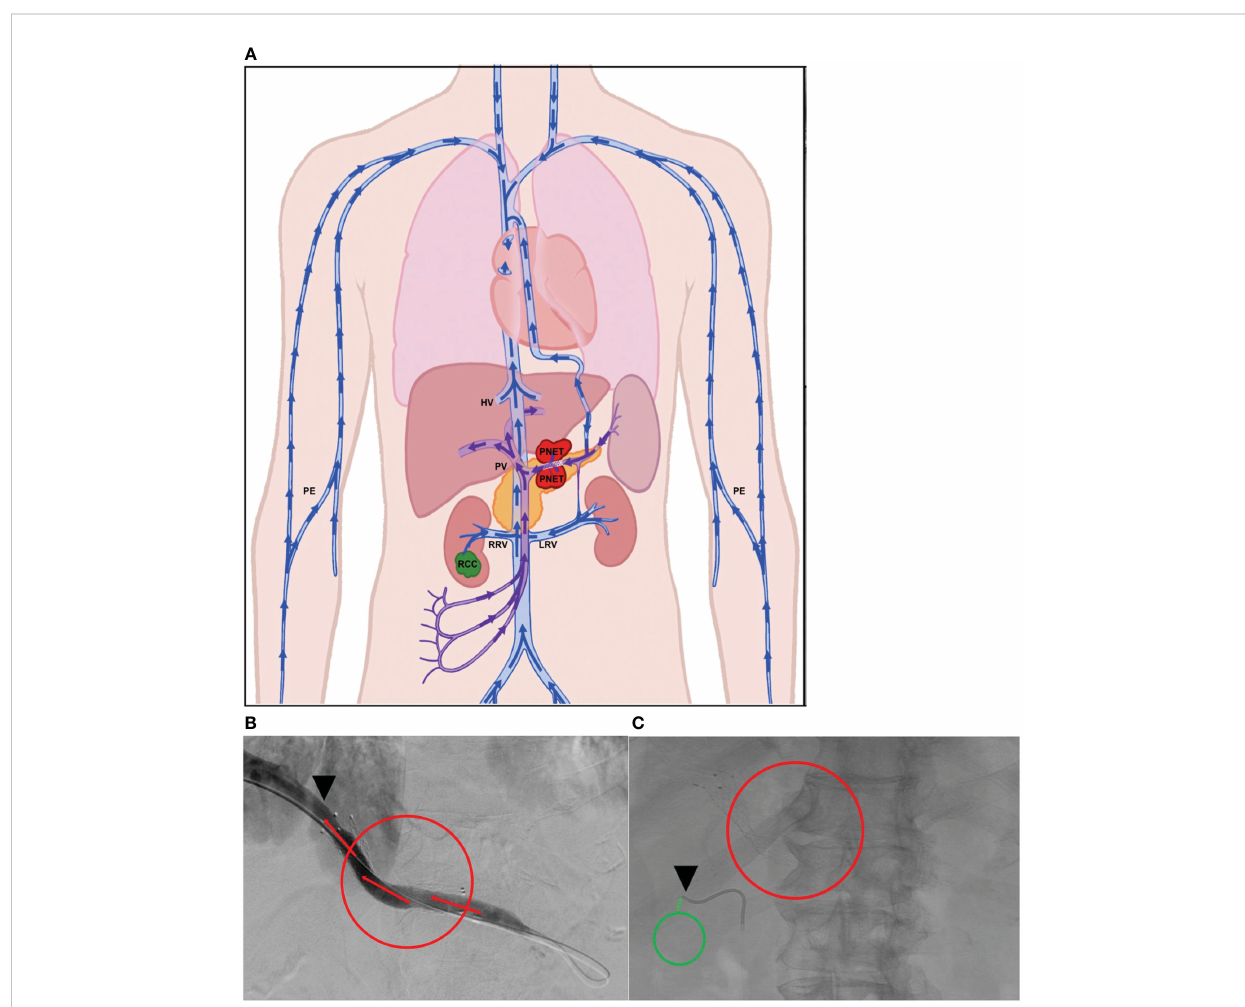
FIGURE 2 Tumor locations and vascular venous compartments for Patient 1. Schematic of pancreatic neuroendocrine tumor (PNET) and renal cell carcinoma (RCC) tumor locations and various vascular venous compartments sampled with targeted liquid biopsy (A) . Intra-procedural image